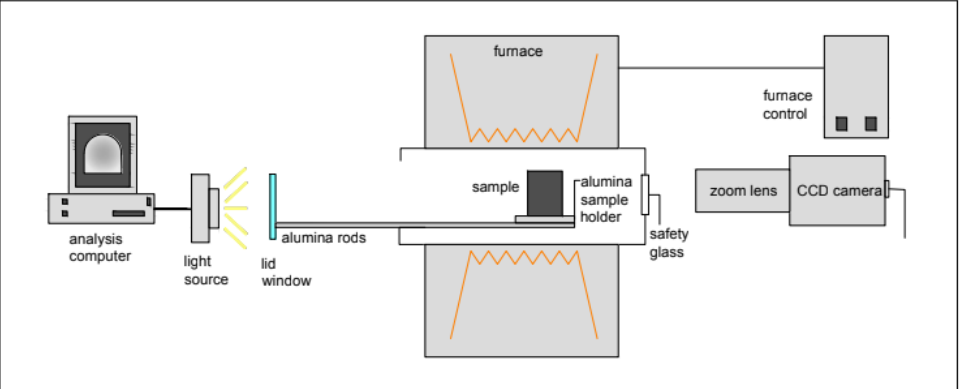
Figure 2. Schematic of Misura Heating Microscope used in this study.